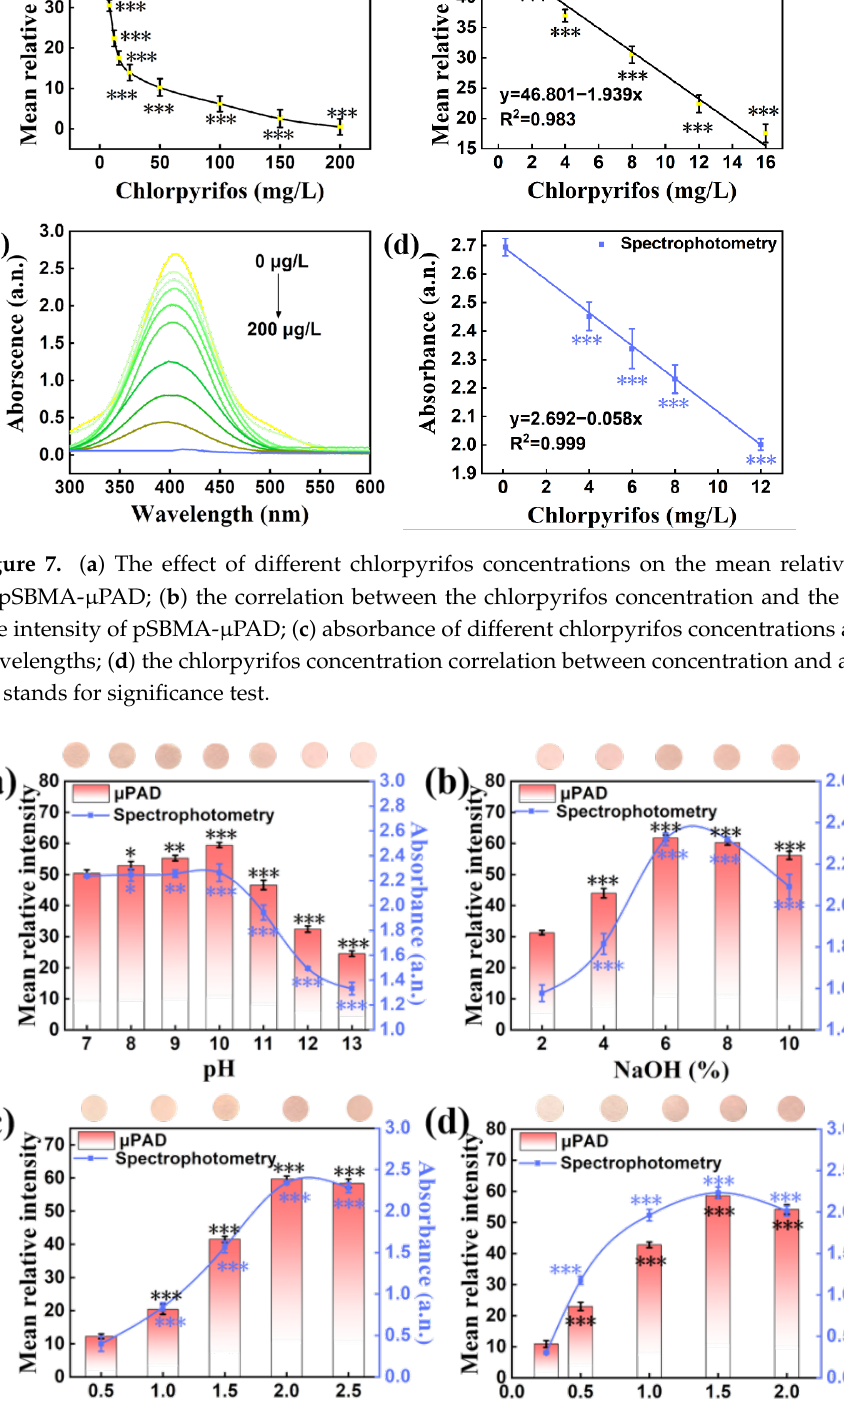
Figure 9. ( a ) The effect of different profenofos concentrations on the mean relative intensity of pSBMA-μPAD; ( b ) the correlation between the profenofos concentration and the mean relative in- tensity of pSBMA-μPAD; ( c ) absorbance of different profenofos concentrations at different wave- lengths; ( d ) the profenofos concentration correlation between concentration and absorbance. “*” stands for significance test.